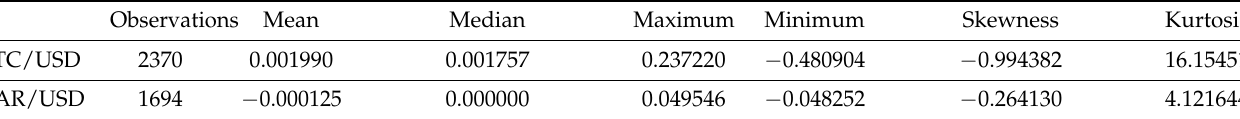
Table 1. Descriptive statistics of exchange rate price